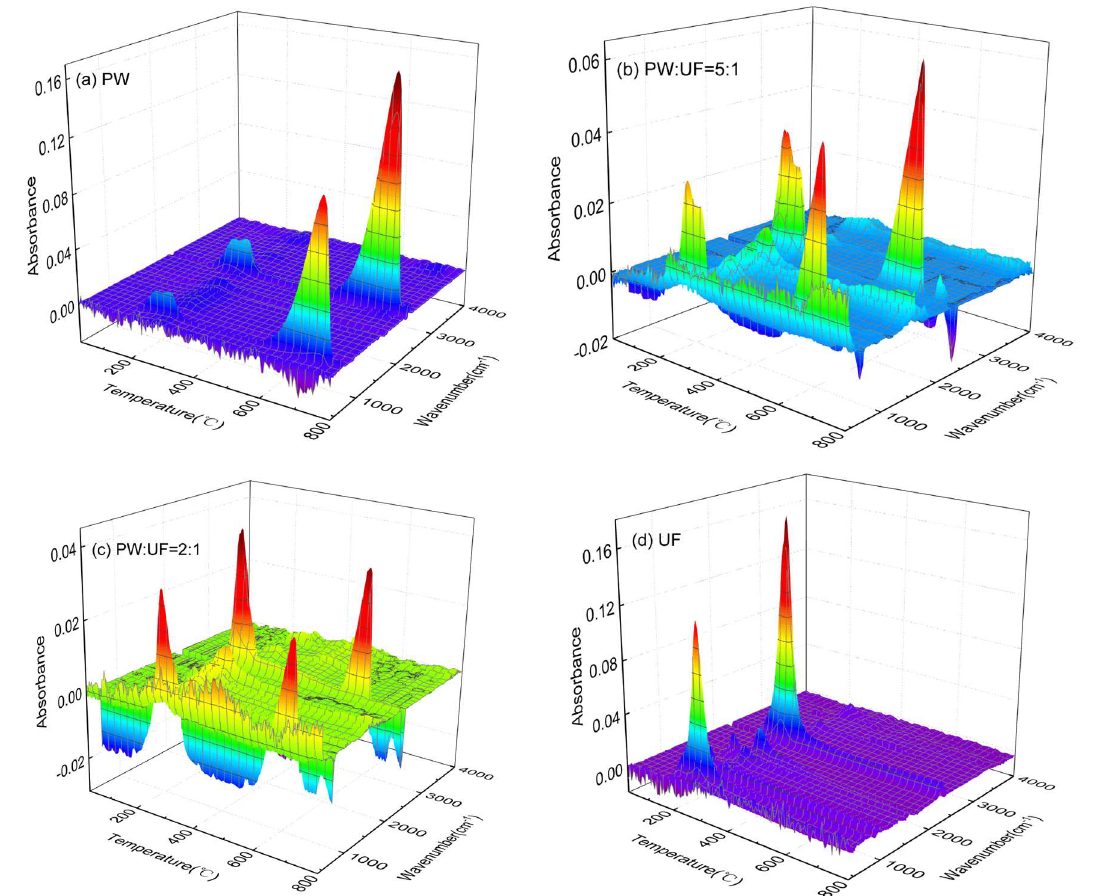
Figure 3. Three — dimensional infrared spectrogram. (( a ) PW, ( b ) PW:UF = 5:1, ( c ) PW:UF = 2:1 and ( d ) UF).